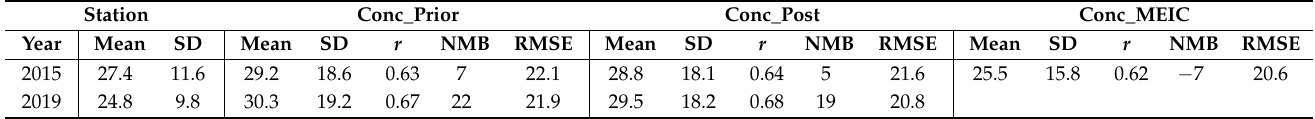
Table 2. Annual statistics for the comparison between simulated and measured NO 2 hourly surface concentrations for 2015 and 2019. Mean = annual mean, SD = standard deviation, RMSE = root mean square error are in µ g/m 3 . r = Pearson correlation coefficient. NMB = normalized mean bias in % ( r , NMB and RMSE formulas are given as statistical indicators in the Supplementary Material), (SDs are calculated using annual means of the